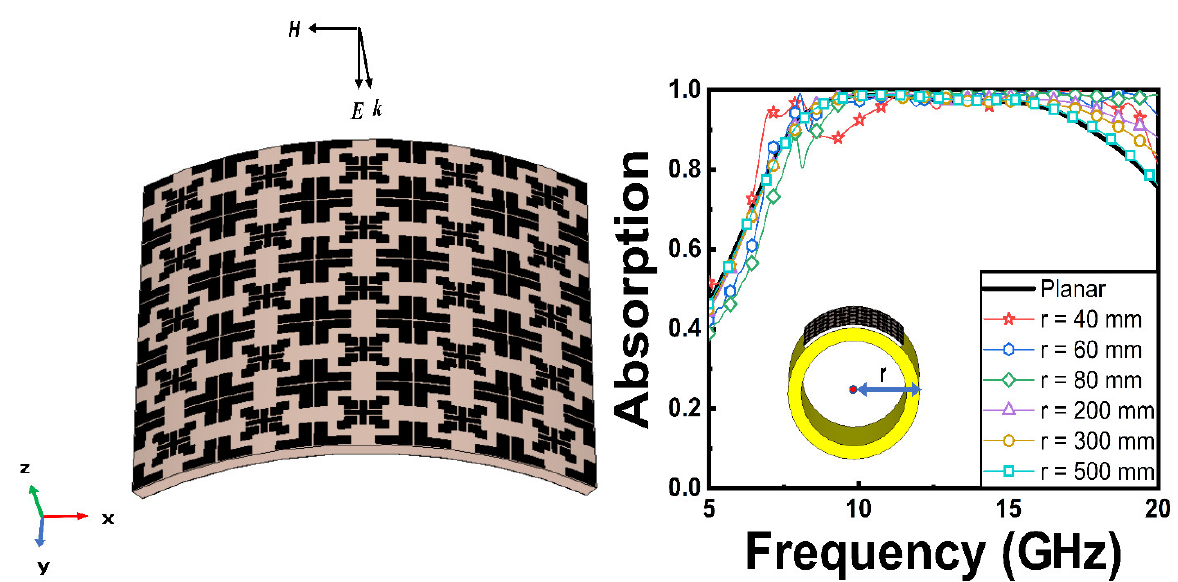
Figure 6. Full-structure of the BBMPA and dependence of the simulated absorption spectrum on bending radius. Table 1. Performance comparison of the proposed FBMPA with recently-reported MPAs by using conductive